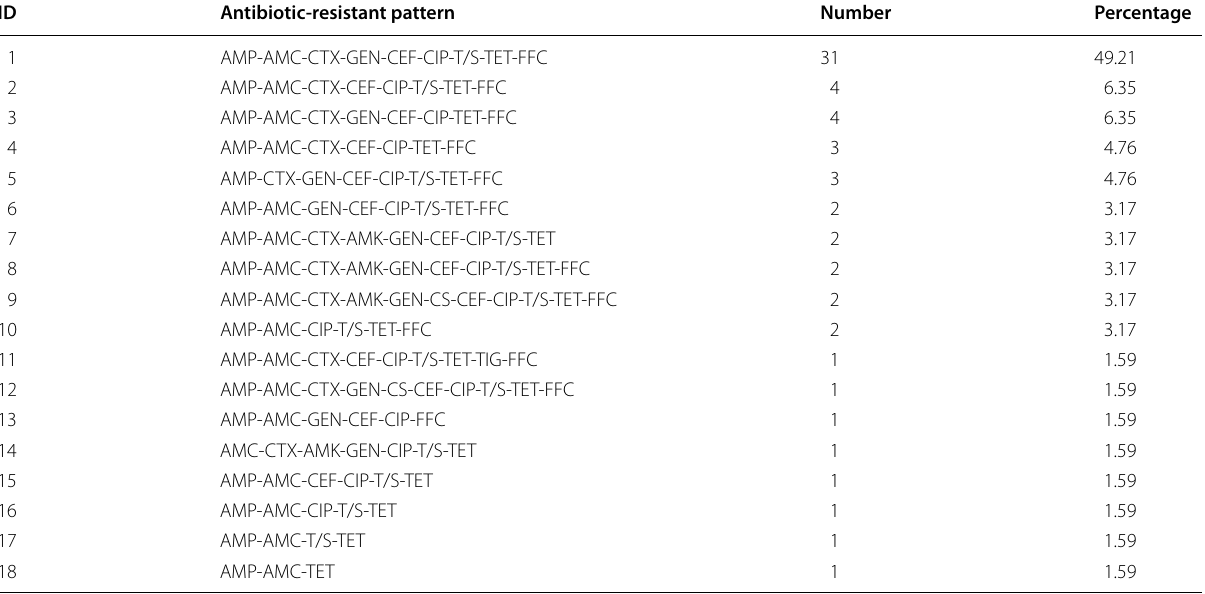
Table 2 The AMR patterns of 63 of E. coli